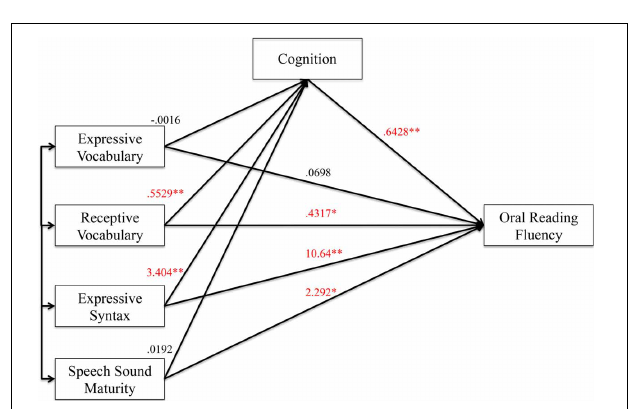
FIGURE 6 | Total effect model (without mediator) for oral reading fluency. Figure 6 shows the total effect model for preschool language and speech measures on oral reading fluency. Unstandardized coefficients of correlations are included in model. Coefficients marked with a single asterisk are significant at the p < 0 . 05 level. Coefficients marked with a double asterisk are significant at the p < 0 . 01 level.